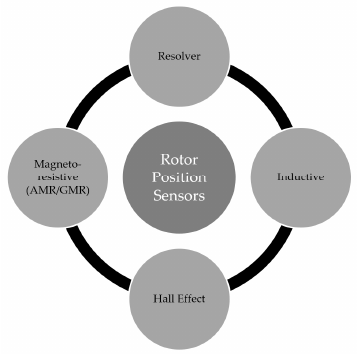
Figure 1. Considered automotive non-contacting rotor position sensor principles.